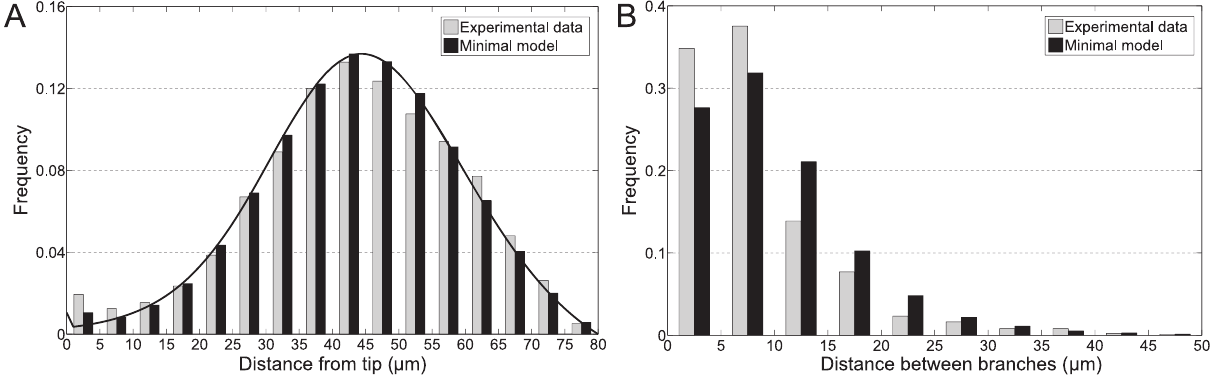
Figure 2. Comparison of histograms between minimal model and experimental data at 80 m m trim. (A) Tip-to-branch distribution. Analytic prediction is also shown (curved line). 1097 experimental data points. (B) Branch-to-branch distribution. 858 experimental data